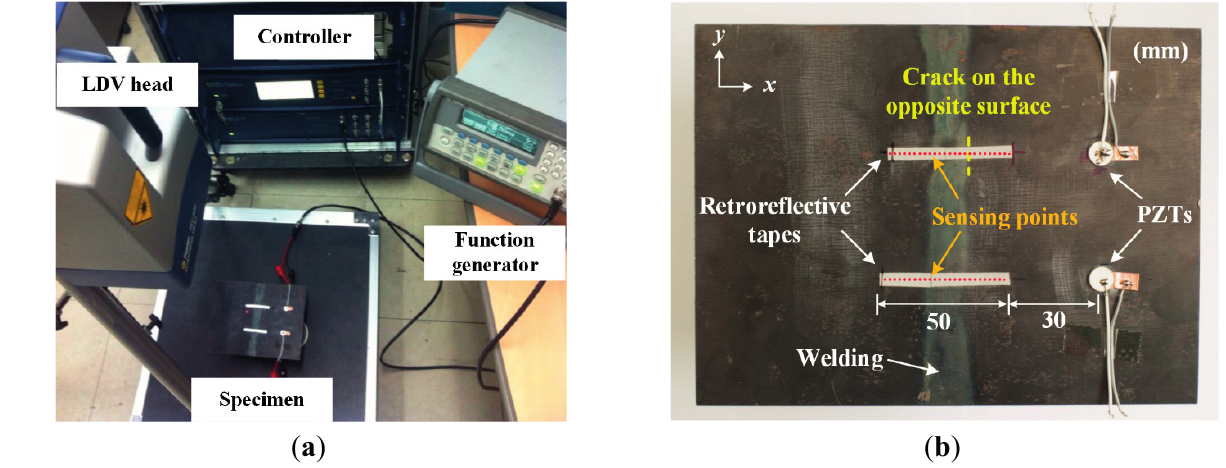
Figure 2. Experimental setup: ( a ) Overview and ( b ) Lamb wave generation and the line sensing